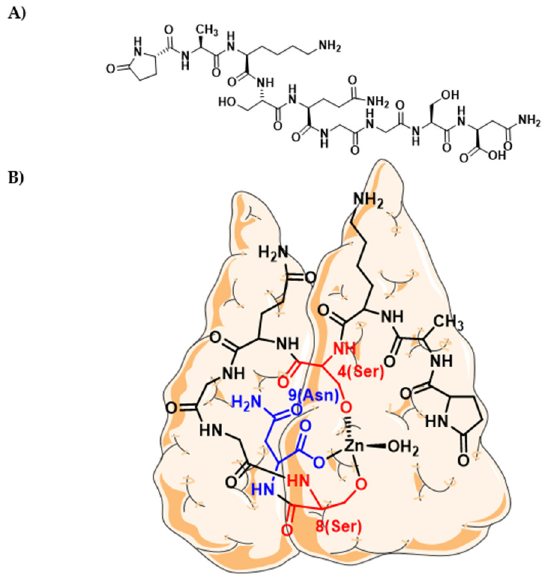
Figure 2. Molecular structure of the hormone thymulin ( A ) and preferred form of chelation of thymulin with Zinc ( B ).